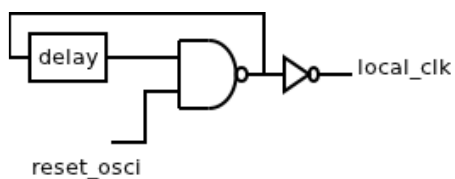
Figure 3. Implementation of the local